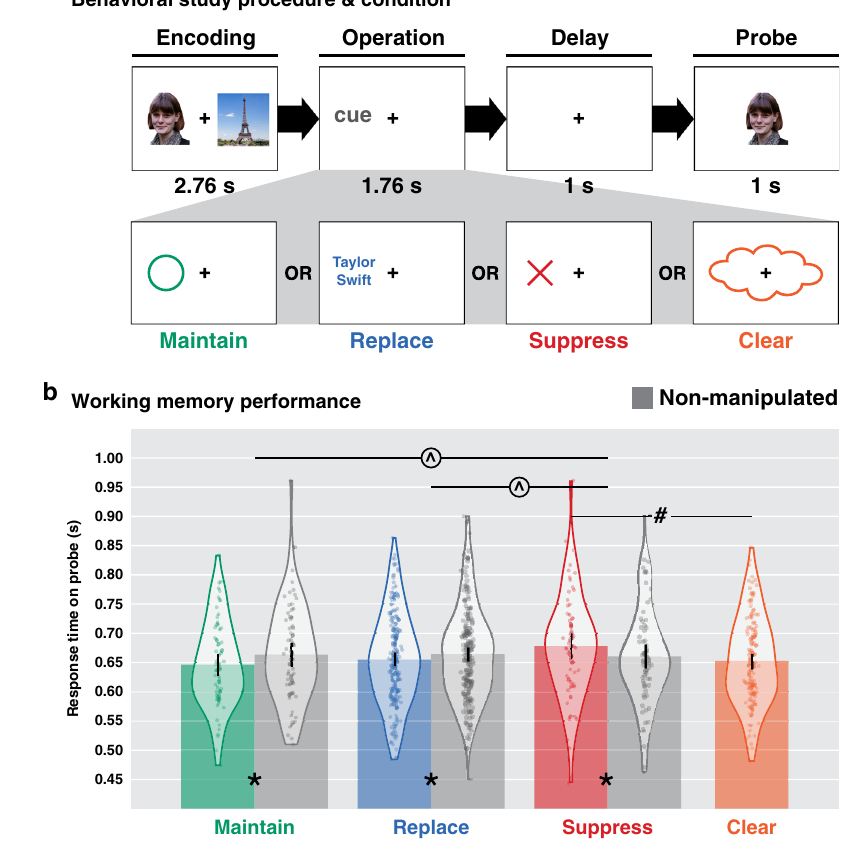
Fig. 6 Behavioral study procedure and results. a Each trial started with two items (one face and one scene) for 2.76 s, followed by a cue for 1.76 s indicating which cognitive operation should be applied to the item that had appeared at the cued location (i.e., the manipulated item). Each cue was linked to one of the four operations based on its shape and color. Then, a 1-s retention interval appeared with central fi xation until a single WM probe appeared. The participants were instructed to respond whether they saw the probe item at the beginning of the trial (regardless of whether or not an operation was performed on the item) as fast as possible within 1 s. b Response times (RTs) for correct Yes probes for different operations by probe type (manipulated, non-manipulated) of the WM items. Data for manipulated items are color-coded by operation and data for non-manipulated items are shown in gray across all operations. Violin plots show the full distribution of n = 208 participants with dots corresponding to individual participants. Error bars indicate 95% CI. *Paired t -test, two-sided, uncorrected, Maintained vs. Non-Maintained P = 0.016, Replaced vs. Non-Replaced P = 0.014, Suppressed vs. Non- Suppressed P = 0.025; # independent t -test, two-sided, uncorrected, Suppressed vs. Cleared P = 0.047; ^mixed-effects model fi xed factors interaction, Maintain vs. Suppress P = 0.001, Replace vs. Suppress P = 0.002. Source data are provided as a Source Data fi